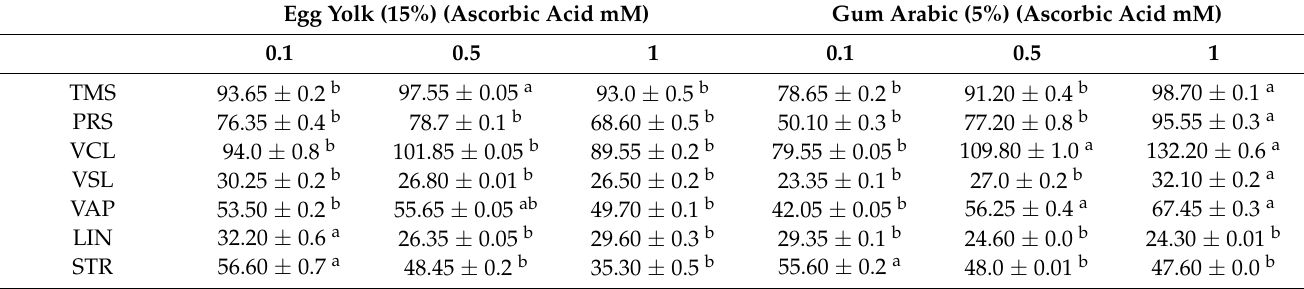
Table 3. Spermatozoa motility and viability parameters (mean ± SEM) in egg yolk and gum ara- bic extenders supplemented with different concentrations of ascorbic acid (0.1, 0.5 and 1 mM) after cooling.